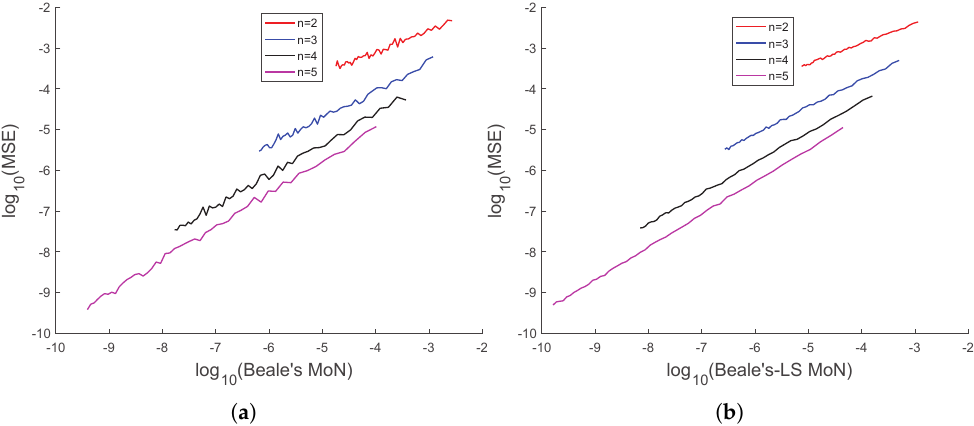
Figure 14. ( a ) log using LS) using 10 scalar measurements.